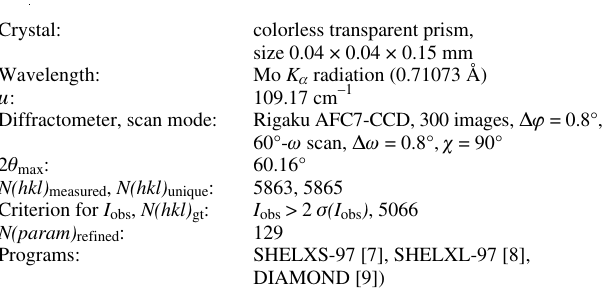
Table 1. Data collection and